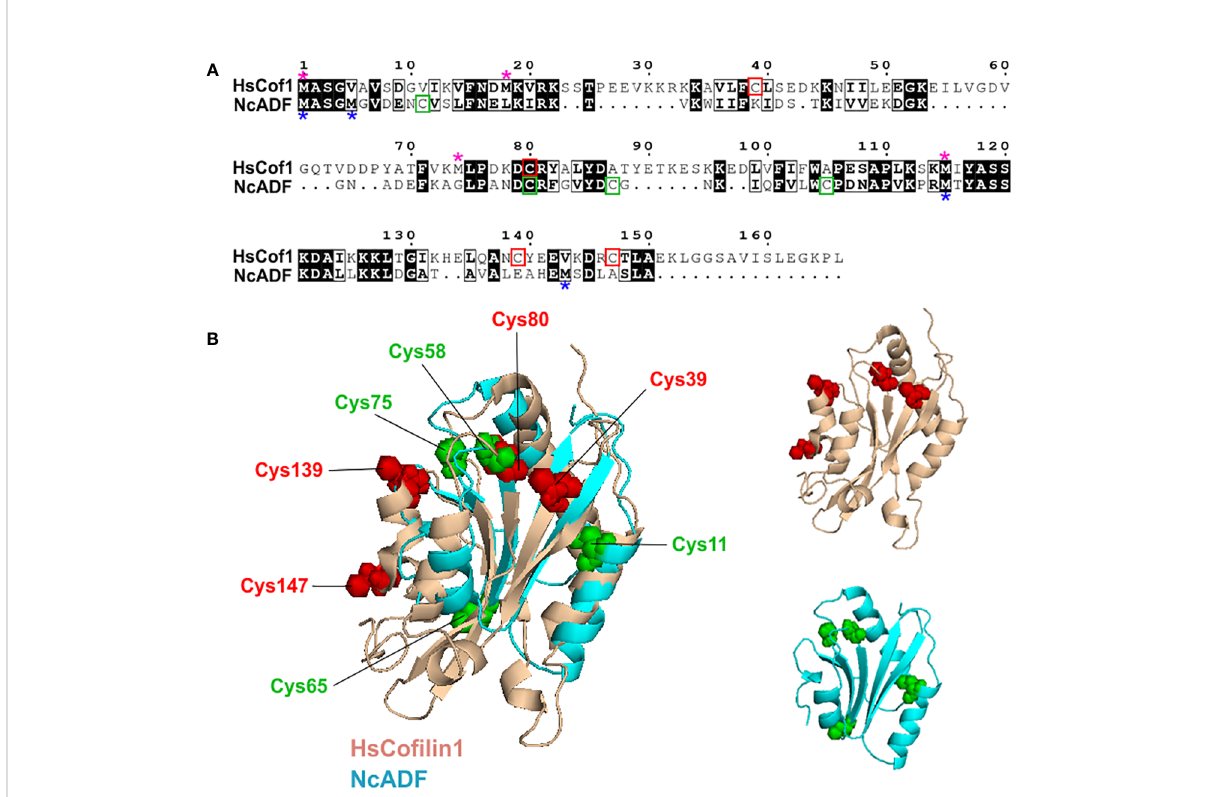
FIGURE 4 Comparison of cysteines ’ position between NcADF and human co fi lin 1. (A) Alignment of human co fi lin 1 (HsCof1) and NcADF primary sequences. The HsCof1 cysteines (red rectangles) and methionines (pink asterisks), as well as NcADF cysteines (green rectangles) and methionines (blue asterisks) are highlighted. (B) The cartoon representations of NcADF (Baroni et al., 2018) and HsCo fi lin1 (PDB: 1q8x) tertiary structures were aligned. The two structures are shown independently on the right. The cysteines are represented as green spheres (NcADF) or red spheres (HsCo fi lin1) and their relative positions are described in the